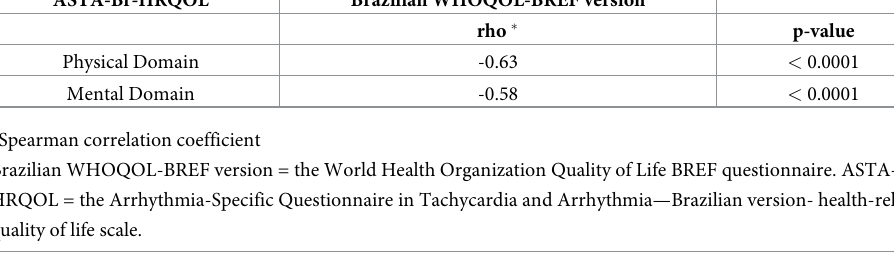
Table 6. Spearman’s correlations between ASTA-Br-HRQOL domain scores and WHOQOL-BREF domains. ASTA-Br-HRQOL